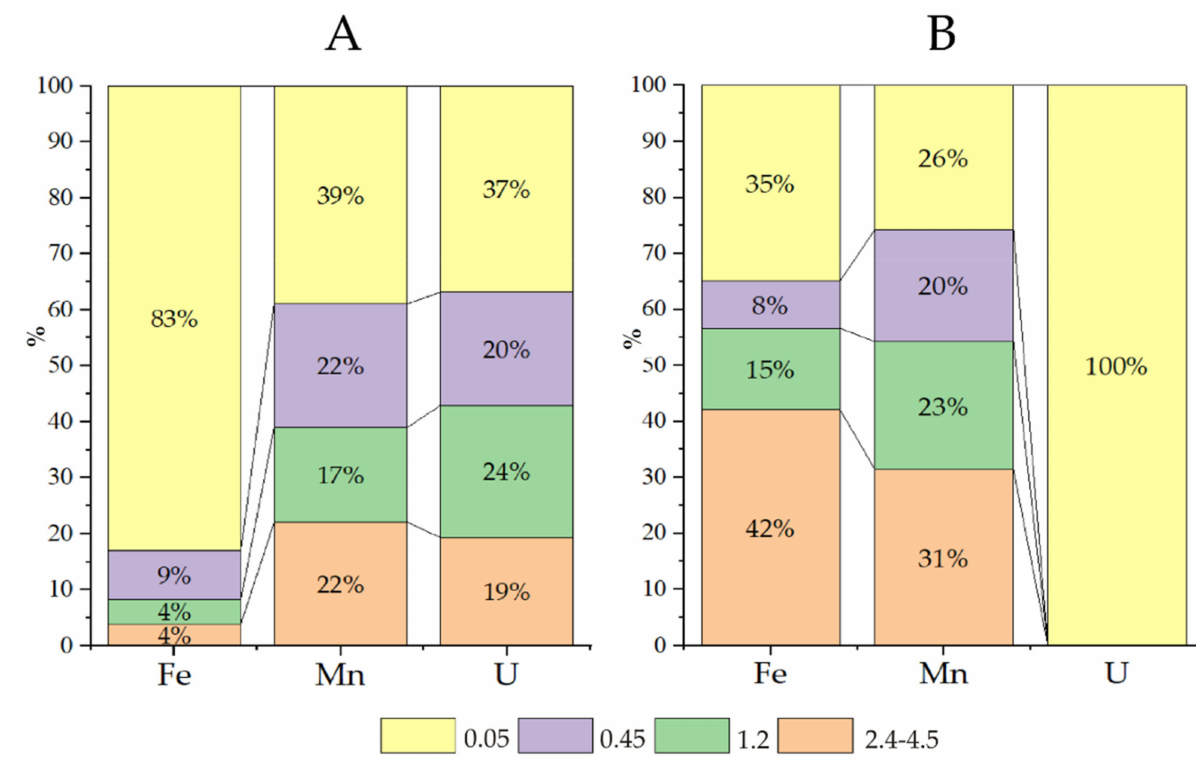
Figure 1. The content of elements in different fractions (% of initial concentration) after cascade filtration of groundwater samples: A —Sample 2, B —Sample 3. The pore diameters of the filters ( µ m) are displayed at the